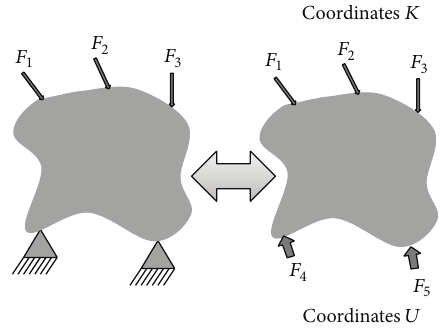
Figure 1: Original supported structure and equivalent structure in dynamic